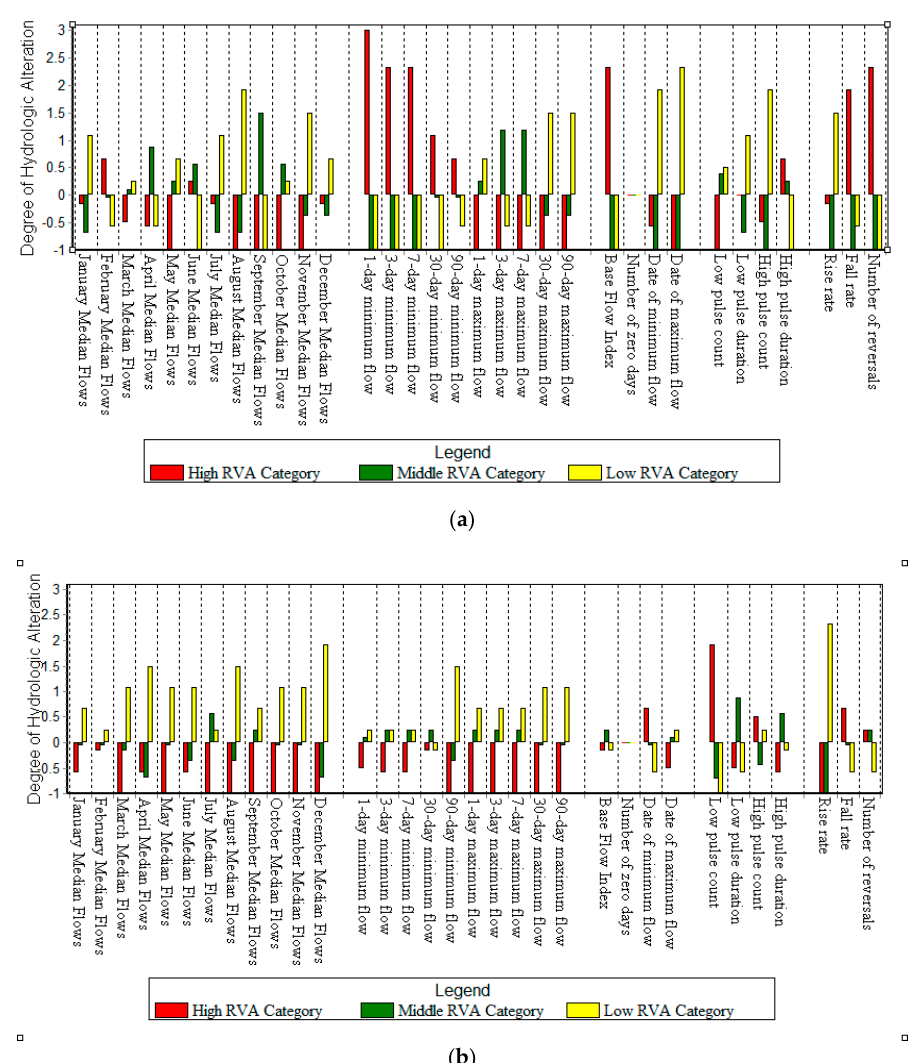
Figure 6. ( a ) Hydrologic alteration of POF approach; ( b ) Hydrologic alteration of simulative flow.